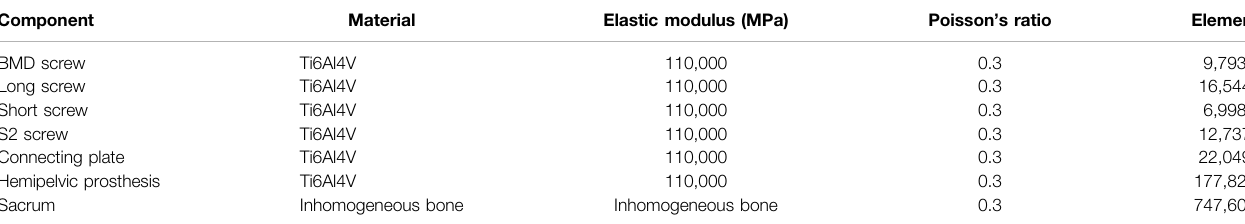
TABLE 1 | The material characteristics of various components.